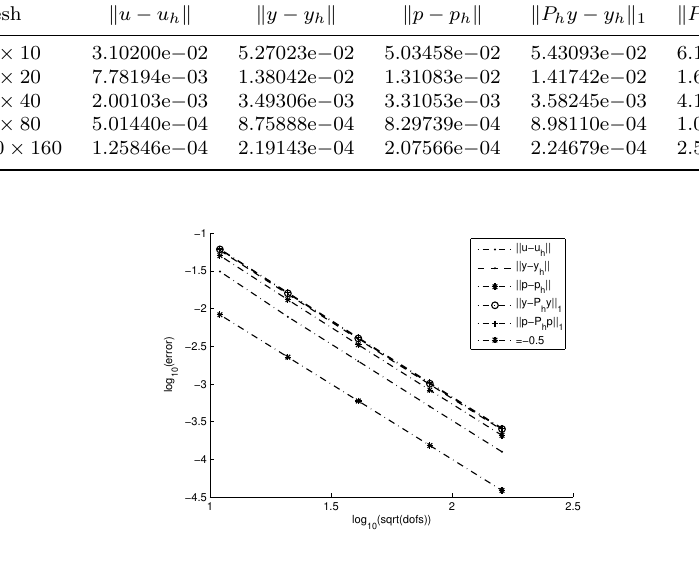
Figure 1. The order of convergence, Example